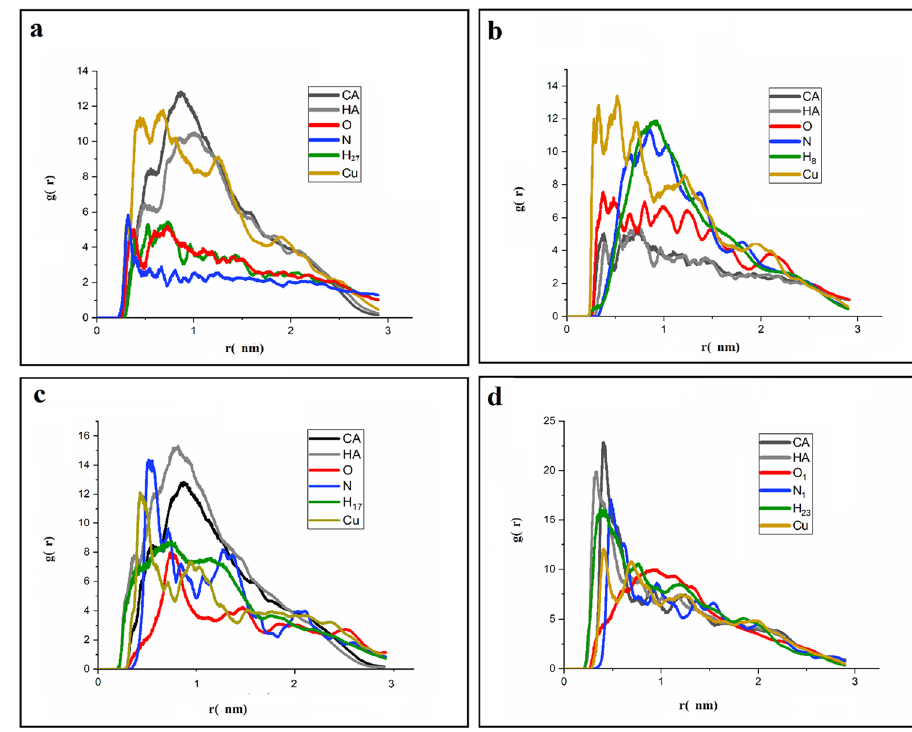
Fig. 4 The atomic RDF patterns. a MOF-Rh B, b MOF-NH 2 , c MOF-OH and d MOF-NO 2 systems.